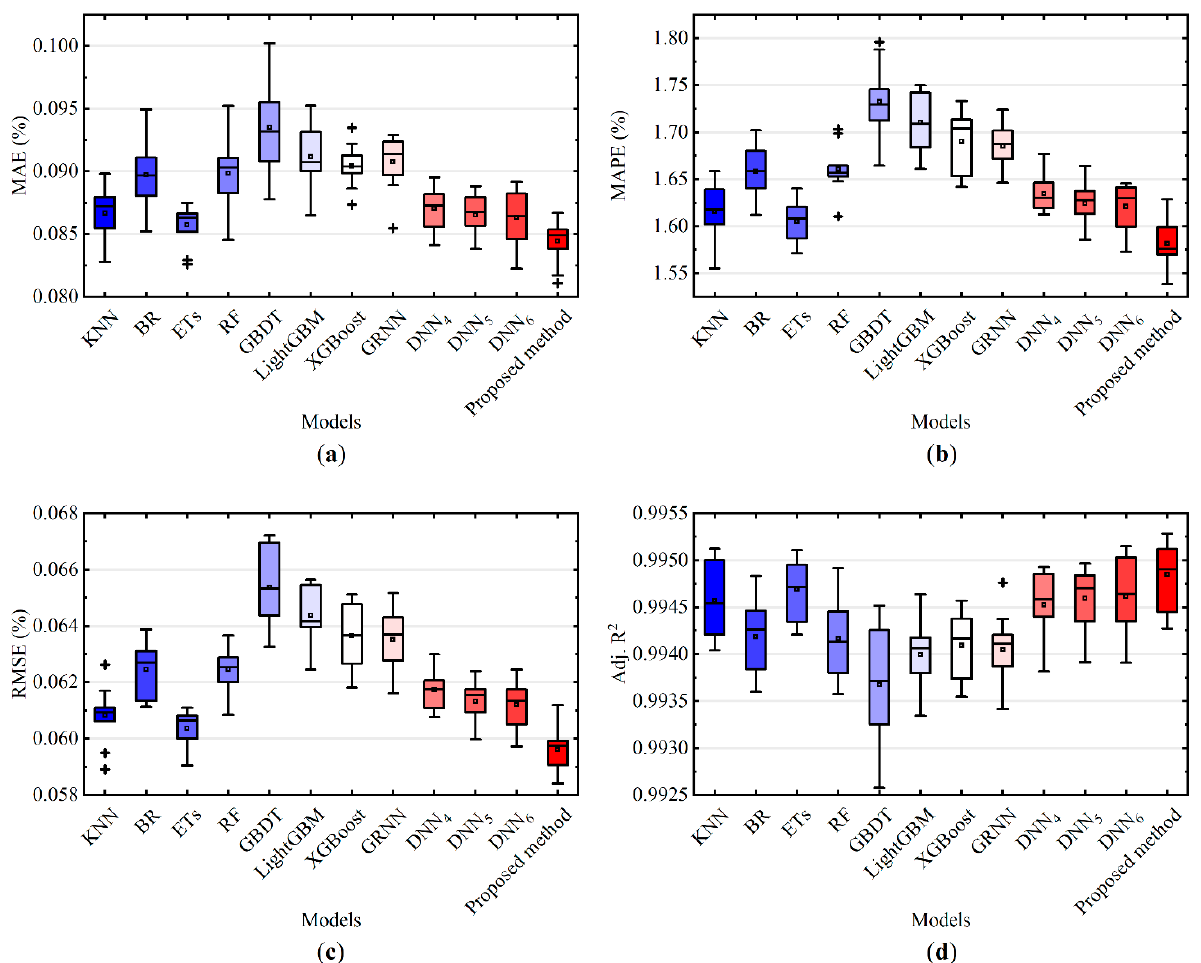
Figure 7. Results for performance evaluation of the proposed stacking method and other models: ( a ) MAE; ( b ) MAPE; ( c ) RMSE; ( d ) Adj. R 2 . Detailed experimental results of all the evaluated models are provided in Table 5.